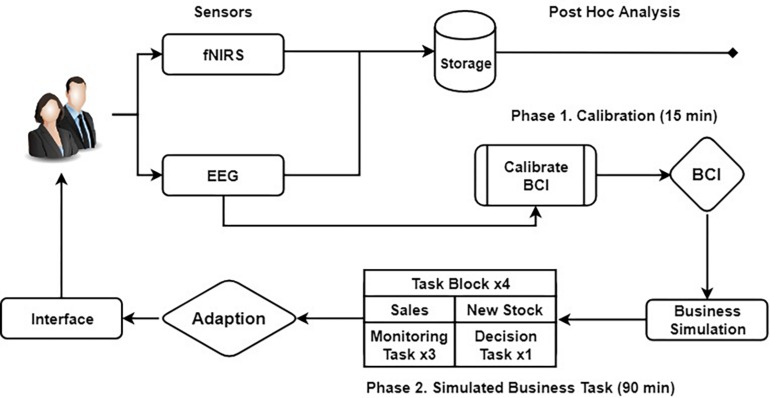
The complete experimental schema and neurofeedback loop visualization.